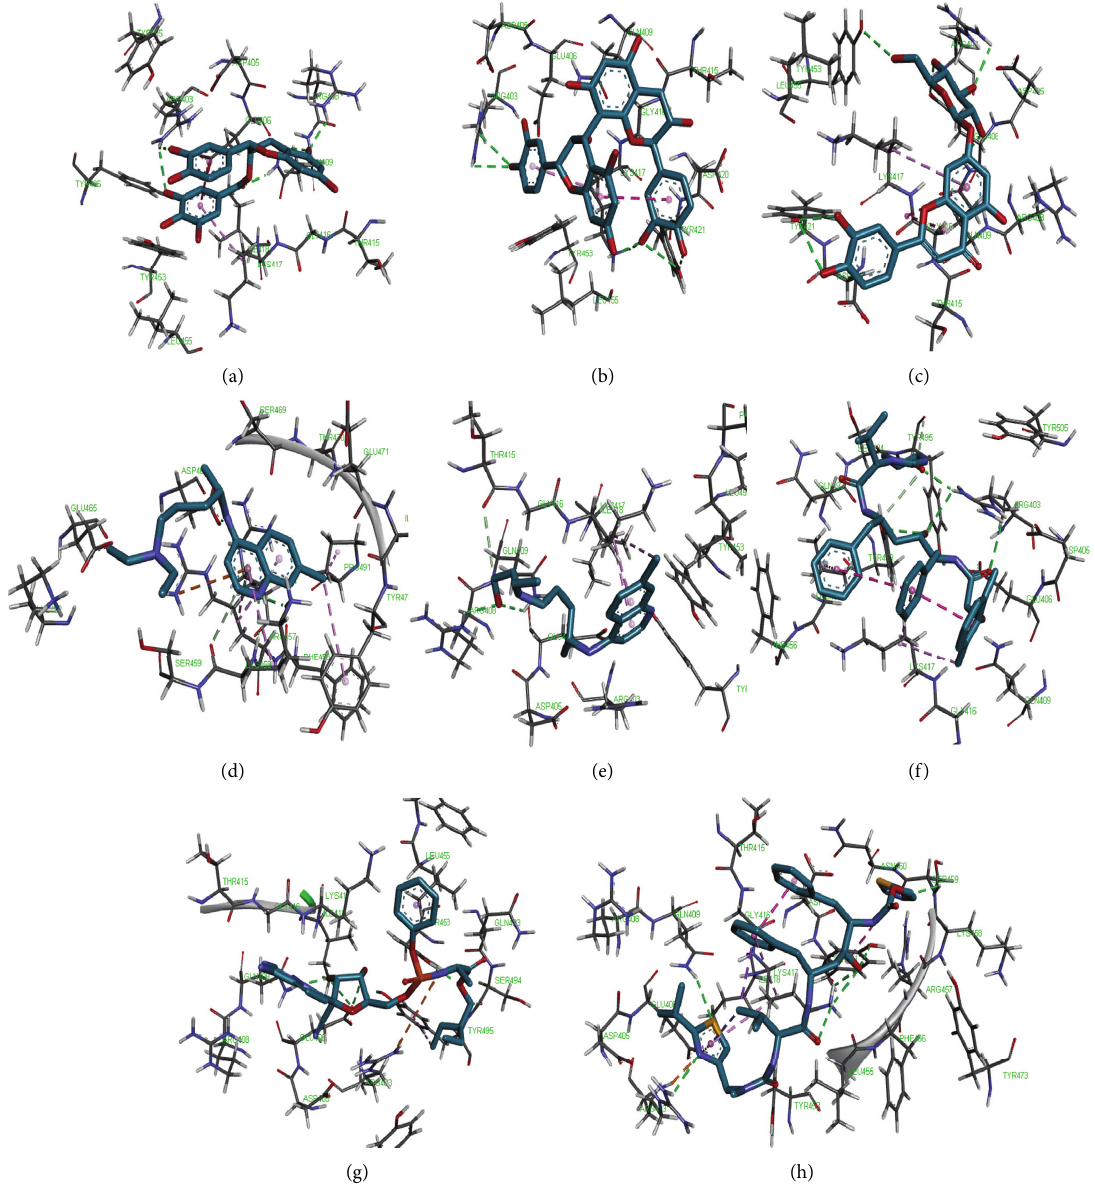
Figure 12: 3D representation of (a) 3-galloylcatechin, (b) proanthocyanidin B1, (c) luteolin 7-galactoside, (d) chloroquine, (e) hydroxychloroquine, (f) lopinavir, (g) remdesivir, and (h) ritonavir in the binding pocket of